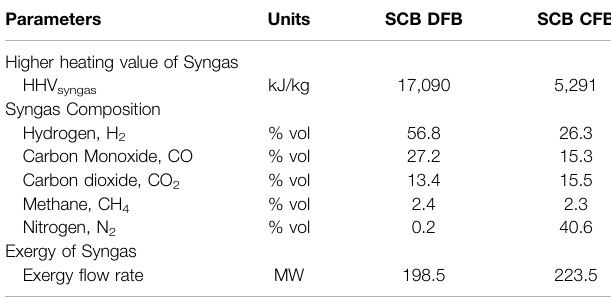
TABLE 2 | Comparison results of selected parameters.